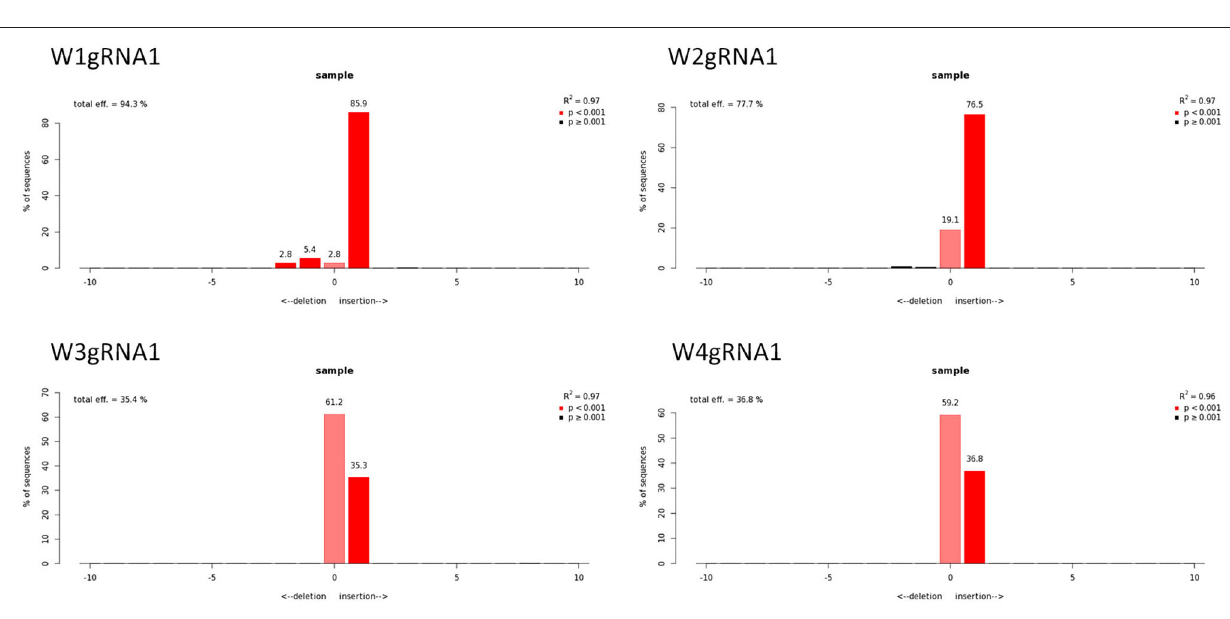
FIGURE 6 | Genotyping of targeted gene mutations induced by CRISPR/Cas9 on gRNA1 in the transformed lines (W1–W4). Editing efficiency and mutagenesis frequencies are